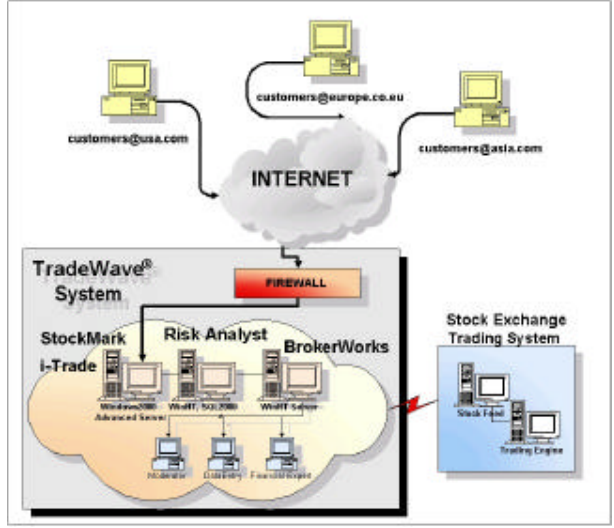
Figure 1: How TradeWave